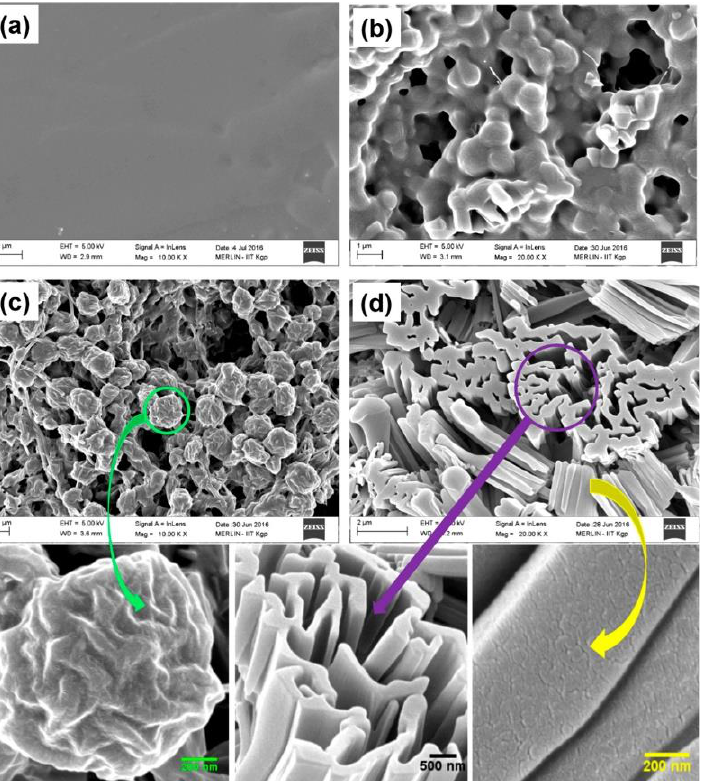
Figure 13. FESEM images of ( a ) native FPU and hybrid composites: ( b ) FPU-POSS-M6, ( c ) FPU-POSS-M12, and ( d ) FPU-POSS-M36. Reprinted with permission from Macromolecules 2018, 51 , 4770–4781 [74] Copyright (2018) American Chemical Society.